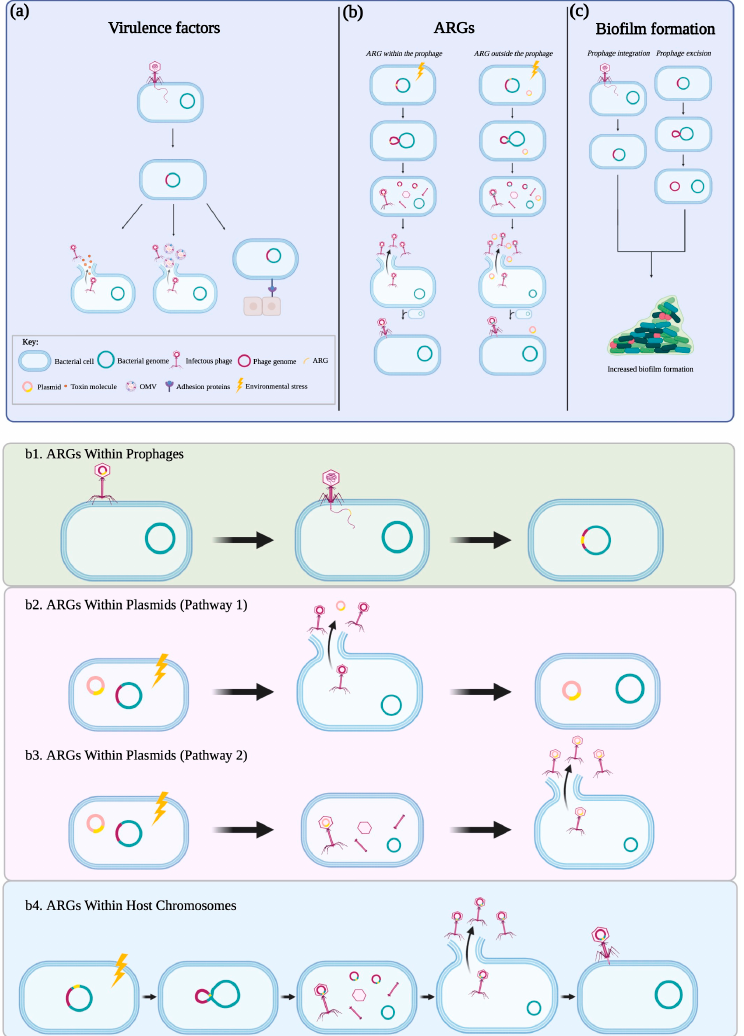
Figure 1. Temperate phages’ contributions to host bacterial pathogenicity. There are three major ways that temperate phages increase the pathogenicity of their host. ( a ) Firstly, temperate phages can transfer the virulence genes encoding for toxins and adhesion proteins to their hosts (leftmost panel). ( b ) Secondly, temperate phages can transfer ARGs originally located within the phage genome or from exogenous sources (host chromosome and plasmids), contributing to the emergence of antibiotic-resistant strains (middle panel). The mechanisms of phage-mediated transfer of ARGs are further demonstrated in detail (bottom panel): ( b1 ) The temperate phage can carry ARGs and then introduce the genes to a new bacterial host genome after phage integration. ( b2 ) During the induction of a temperate phage, the host cell lyses and releases an intact ARG-containing plasmid, which can enter a new bacterial cell through transformation. ( b3 ) In some cases, an ARG-containing plasmid can mistakenly be packaged in a phage capsid and subsequently transferred to a new bacterial cell by phage transduction. ( b4 ) The temperate phage can collect ARGs from the bacterial chromosome by generalized or specialized transduction. ( c ) Finally, gene transfer by temperate phages can promote bacterial biofilm formation through either their integration into or excision out of the host genome, increasing the host’s resistance to antimicrobial treatments (rightmost panel). Abbreviations: OMVs, outer membrane vesicles; ARG, antibiotic resistance